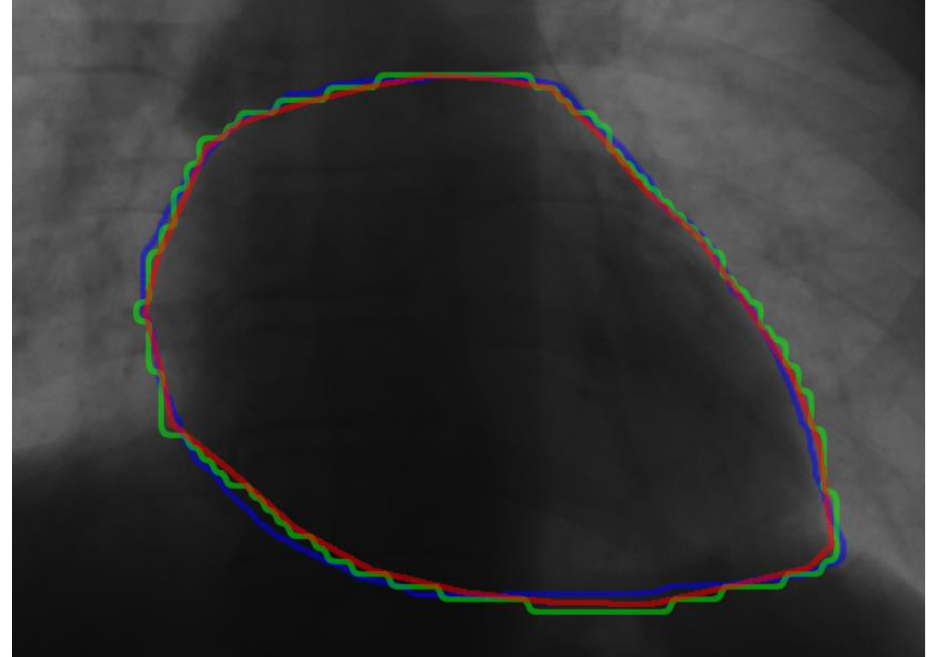
Figure 12. Postprocessing segmentation results. ( The green line: directly enlarged outline. The blue line: the postprocessed result. The red line: the ground truth.)